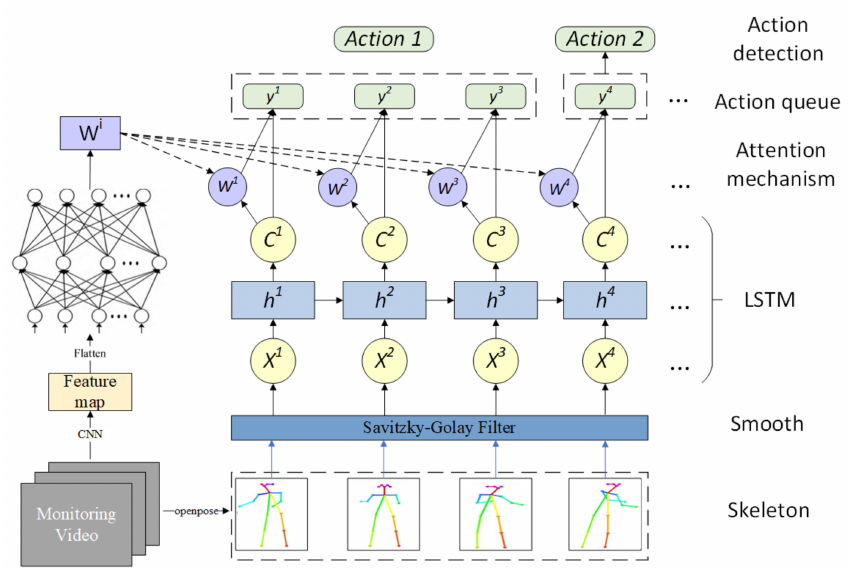
Figure 2. The overall framework of WA-LSTM. The method takes continuous frames of monitoring video as input and consists of two branches. One branch predicts the skeleton position of the worker and inserts it into the LSTM, while the other extracts the workpiece feature to be used as an attention mechanism to boost the